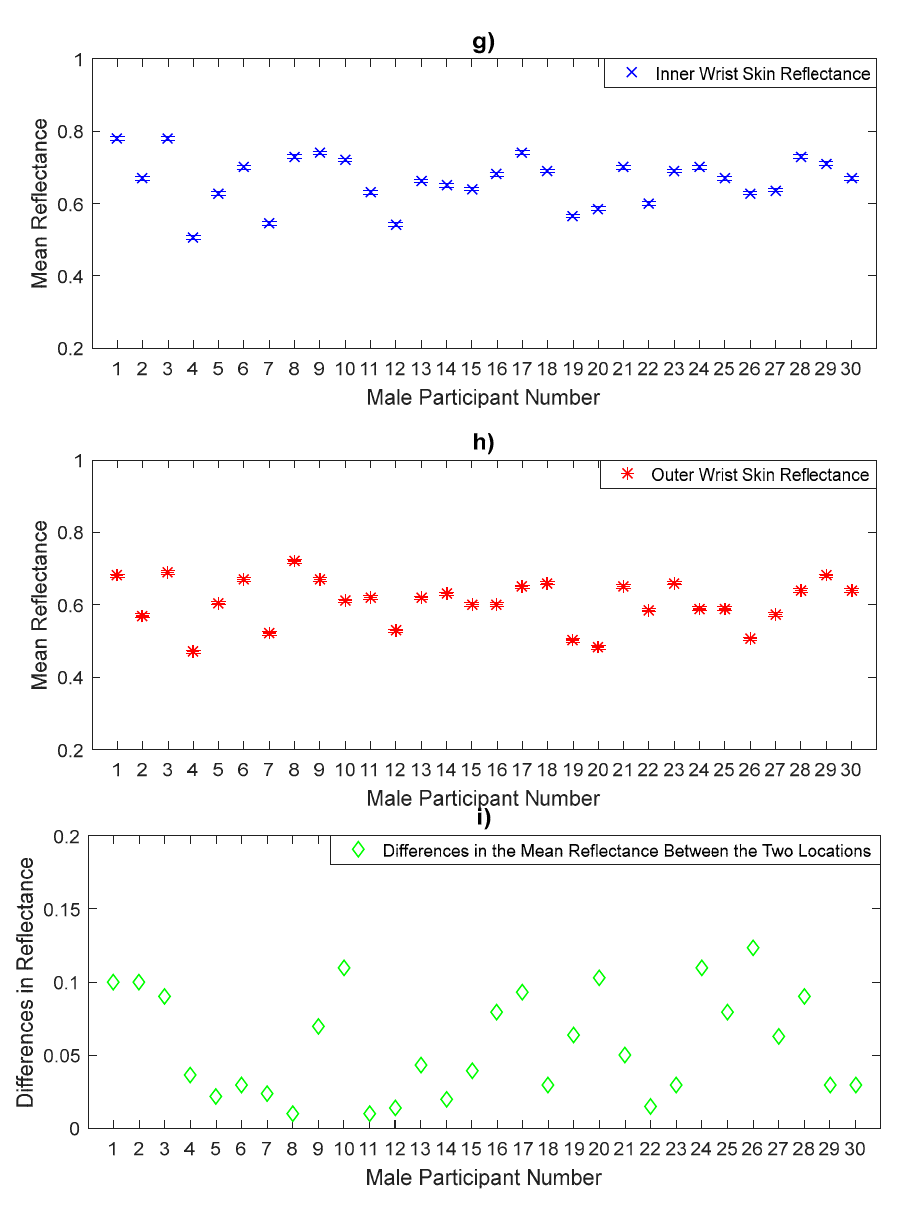
Figure 10. Measurements of human skin reflectance on the inner wrist ( g ) and the outer wrist ( h ) for a sample of 30 male participants. The mean differences in reflectance values between the two locations ( i ) are in the range of 0.01 to 0.123.